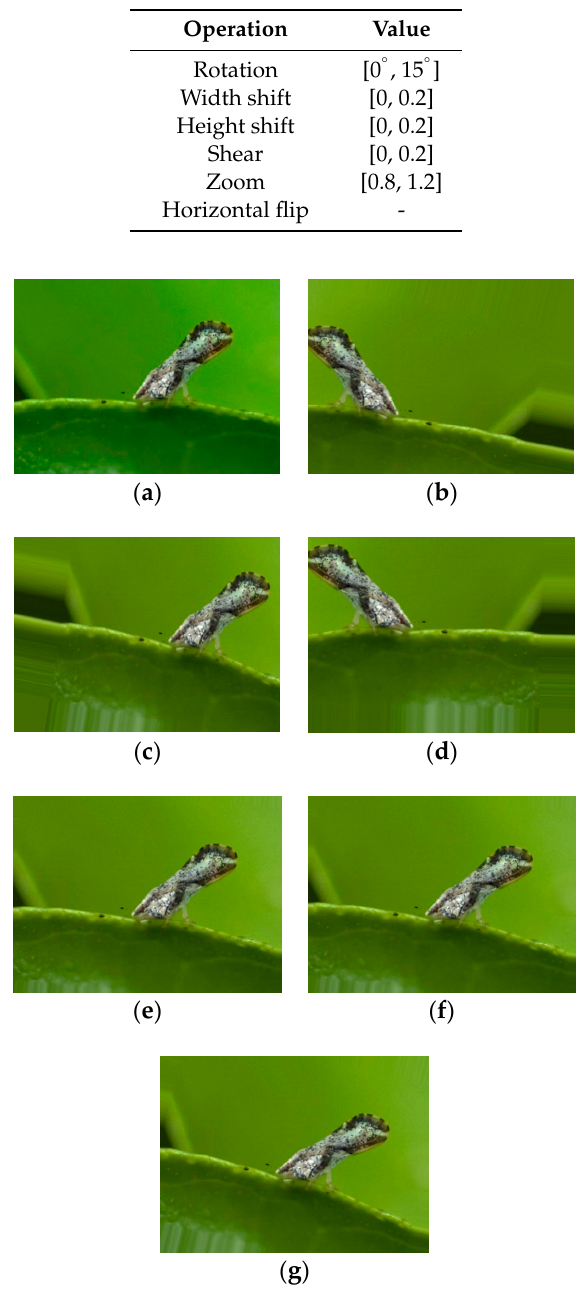
Figure 4. Comparison between different data augmentation methods. ( a ) Original image, ( b ), ( c ), and ( d ) images generated from proposed algorithm, ( e ), ( f ), and ( g ) pictures produced by a single rotation operation.